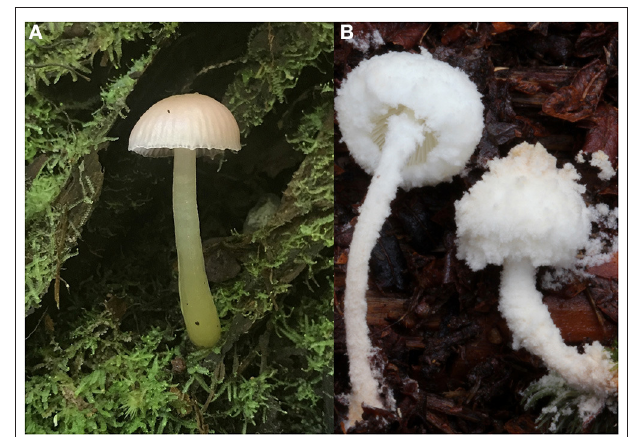
FIGURE 1 | Hygrocybe noelokelani , an endemic, endangered Hawaiian mushroom species. Photograph by Amy Durham (A) . Endemic, undescribed Cystolepiota sp. sensu Hemmes and Desjardin (2002) (B)